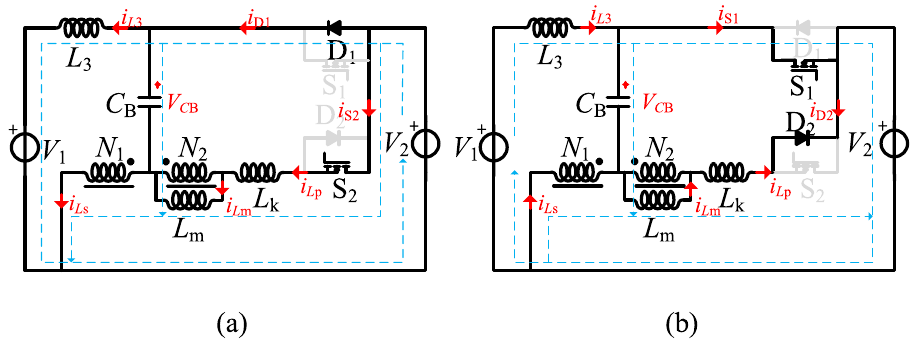
Figure 7. A reverse coupling tapped-inductor high gain bidirectional Cuk equivalent circuit, ( a ) step-up mode, ( b ) step-down mode.